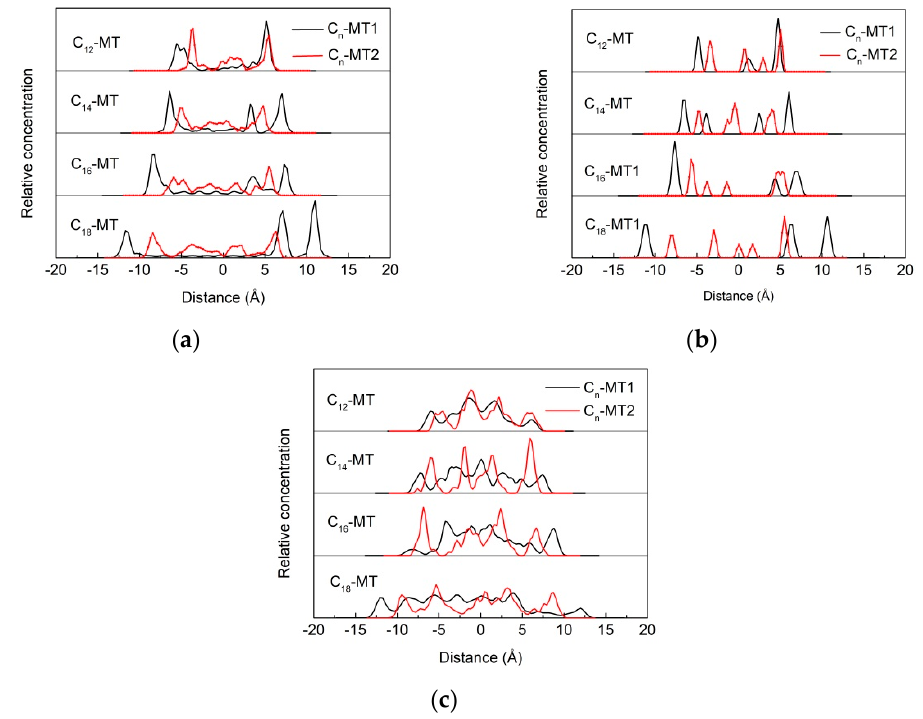
Figure 6. The z-axis concentration curves of C, N, and H 2 O within organo-MT sheets. ( a ) C, ( b ) N, and ( c ) H 2 O.